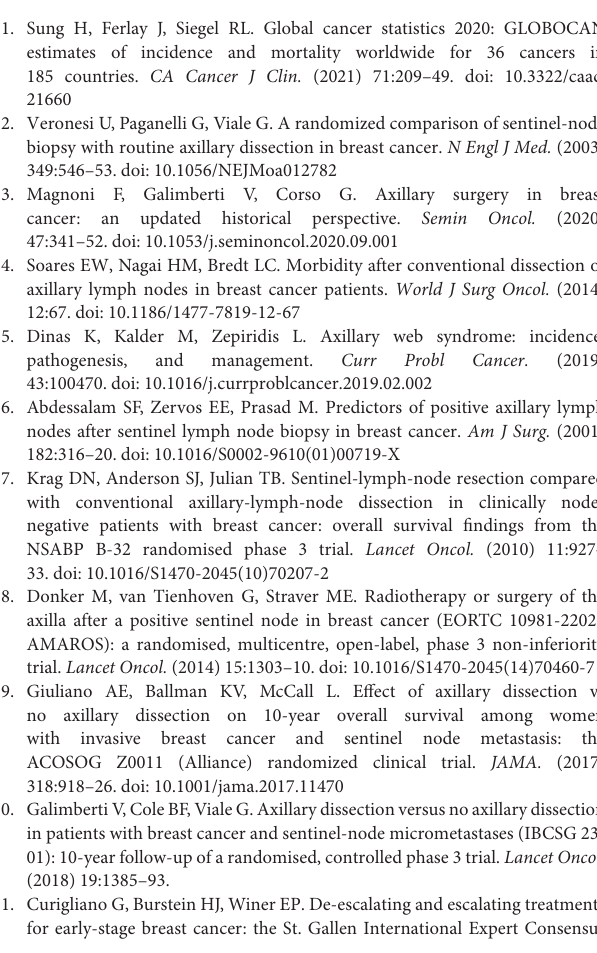
Supplementary Figure S1 | The line graph shows the relationship between the continuous variables and the risk of non-sentinel lymph nodes (NSLNs) metastasis status by using restricted cubic splines analysis. Y-axis means risk ratio and the X-axis means values of variables. (A) age; (B) tumor color Doppler flow imaging